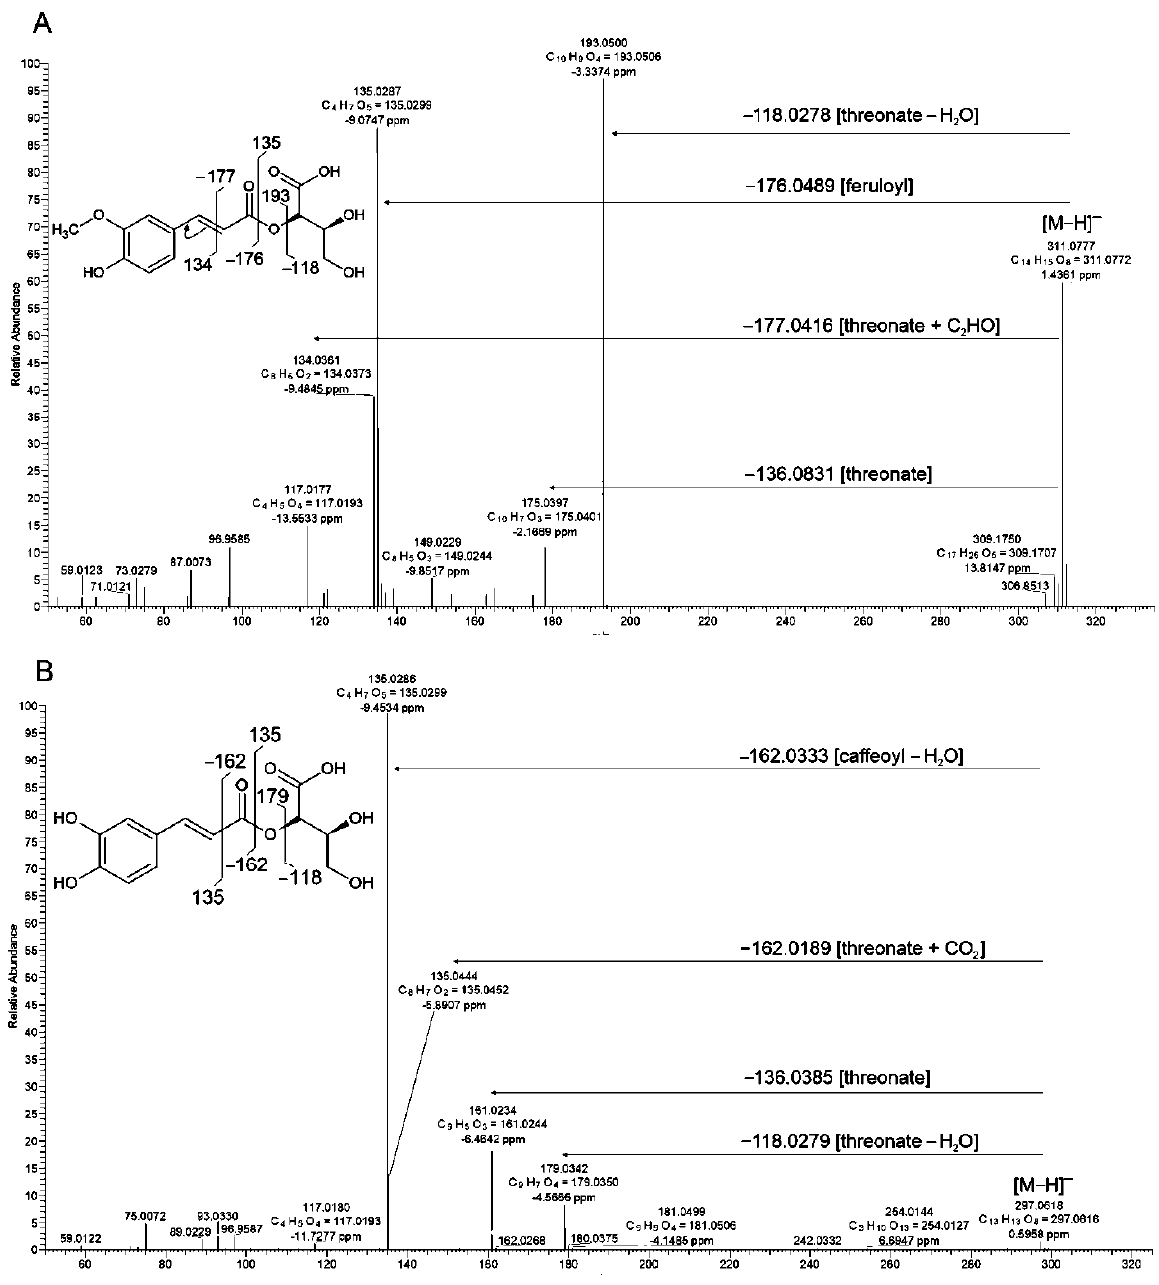
Figure 5. High resolution MS/MS spectra with simplified fragmentation schemes obtained in negative ionization. ( A ) compound 42 , feruloylthreonic acid, and ( B ) compound 18 , caffeoylthreonic acid. Postulated structures are shown as 2- O -threonate, however, precise esterification position on threonic acid cannot be solved by MS fragmentation analysis.